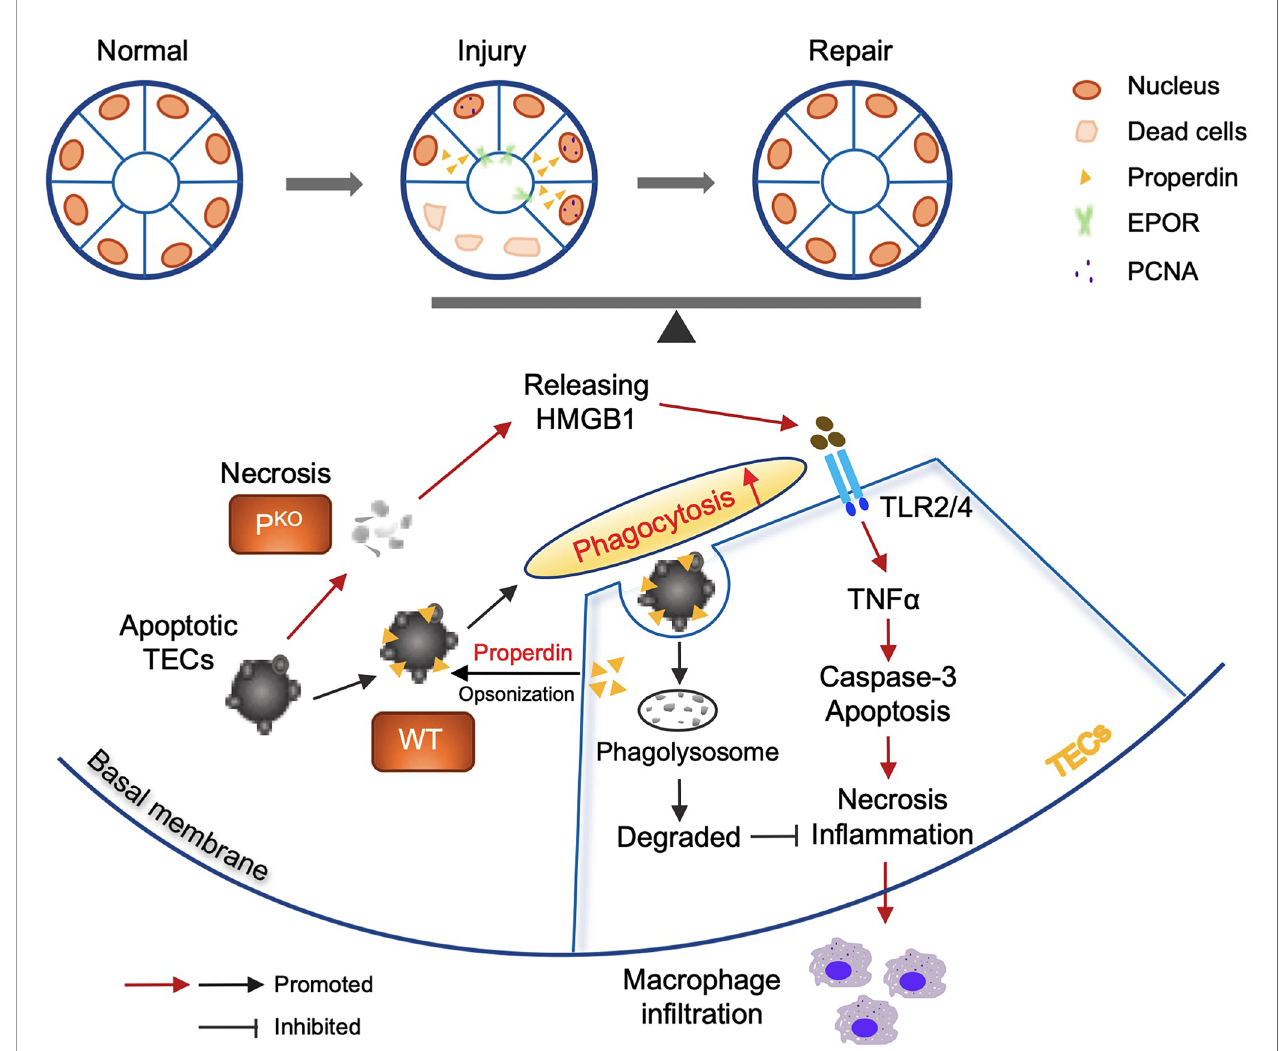
FIGURE 8 | Properdin mediated and enhanced phagocytosis of TECs. Schematic illustration of the role of properdin in the phagocytosis of living TECs from WT and P KO mice. Properdin produced by living TECs tags adjacent apoptotic TECs to facilitate their uptake by neighbor living TECs, promoting damage reduction and in fl ammatory clearance. Lack of properdin impaired TECs phagocytosing damaged cells and resulted in more severe in fl ammation and tissue damage and compromised repair activities. Thus, properdin associated phagocytic function of TECs facilitates the balance between injury and repair of the